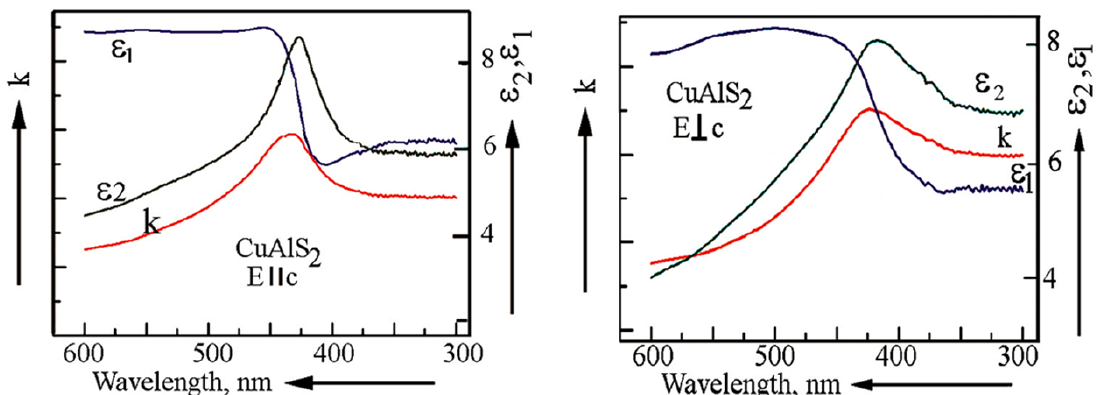
and k for polarizations E||c (left) 1 ε 2, crystals with thickness of 93 2